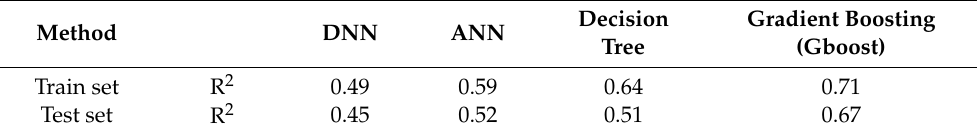
Table 5. The validation of the developed models in simulating the TDS values in precipitation based on R 2 values.